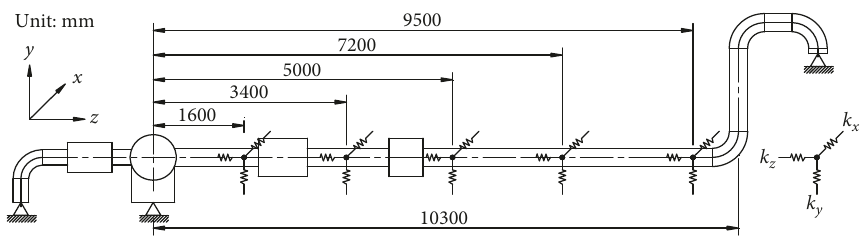
Figure 7: Boundary conditions and locations of supports of the inlet pipeline modifications.